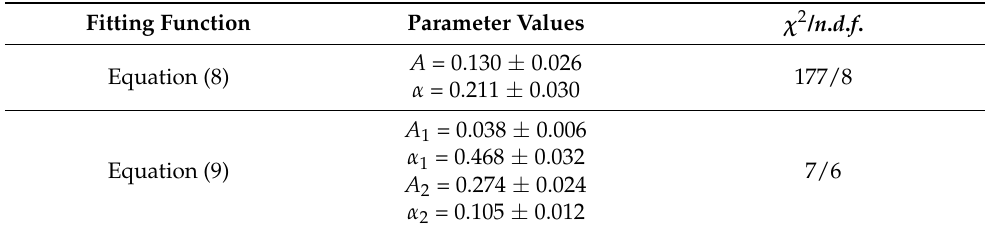
Table 5. The results of minimum χ 2 fits with the functions in Equations (8) and (9) of β T versus (cid:104) dN (cid:105) dependence in Figure 3c, obtained using consistent Tsallis function with transverse flow ch / d η (Equation